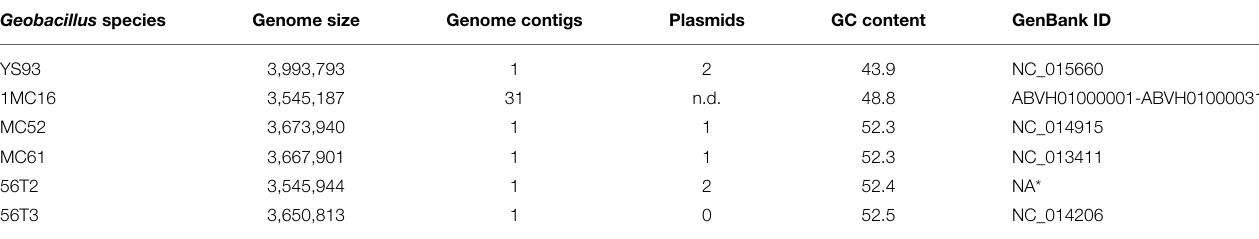
TABLE 3 | Geobacillus sequencing results.